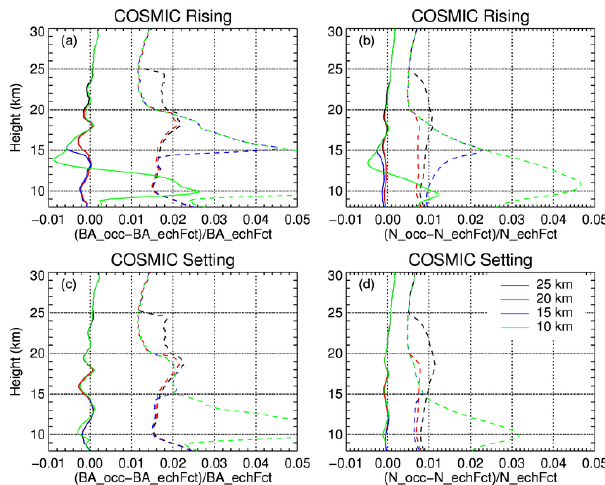
Figure 6. Similar to Fig. 5, except for the COSMIC L2P rising (a, b) and setting (c, d) occultations, for all